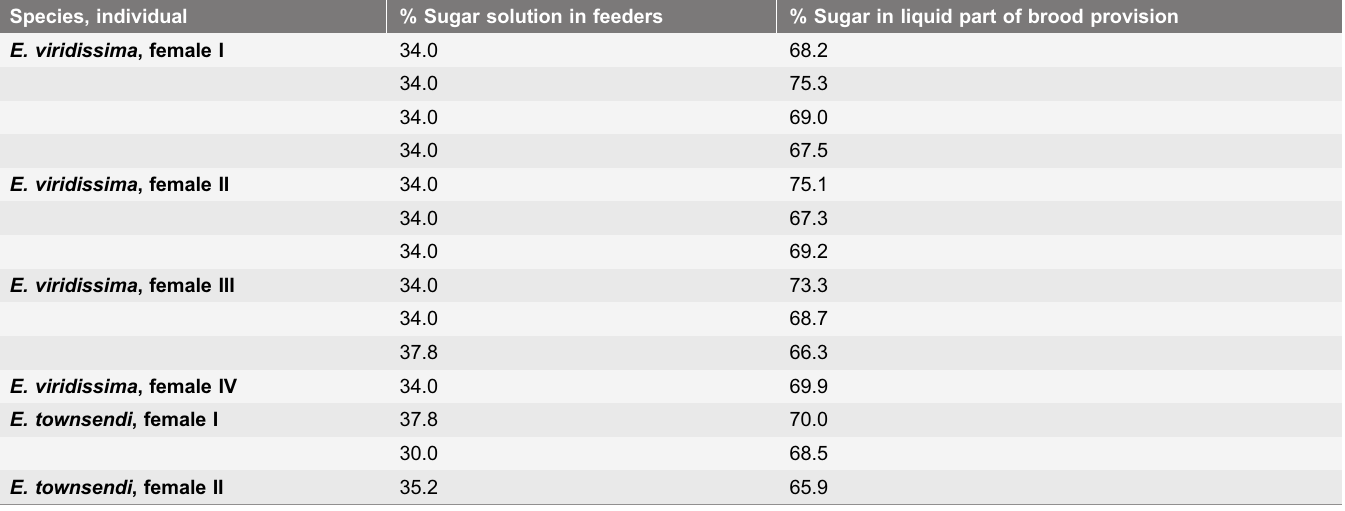
Table 3. Differences in sugar concentration between offered sugar-water and liquid content of freshly deposited brood provisions. Species, individual % Sugar solution in feeders % Sugar in liquid part of brood provision E. viridissima , female